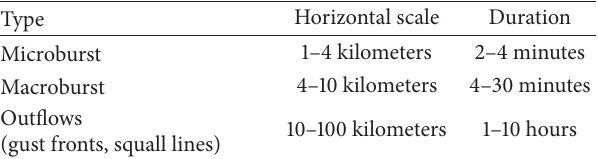
Table 1: Types of thunderstorm winds in